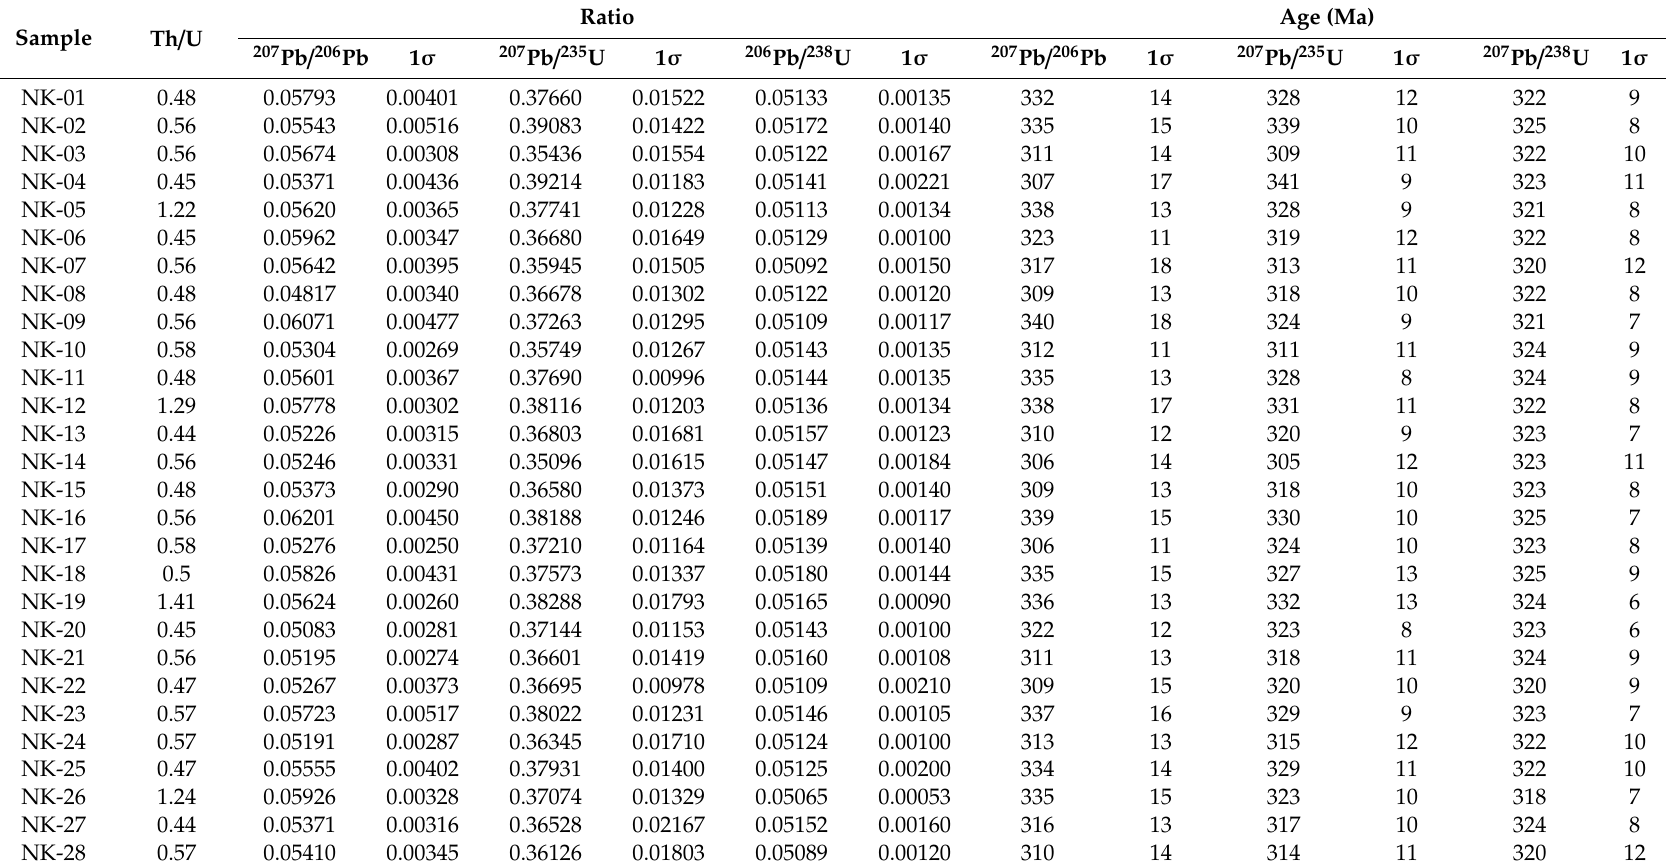
Table 1. U-Pb dating results of North-Karamay granitoids and Hongshan